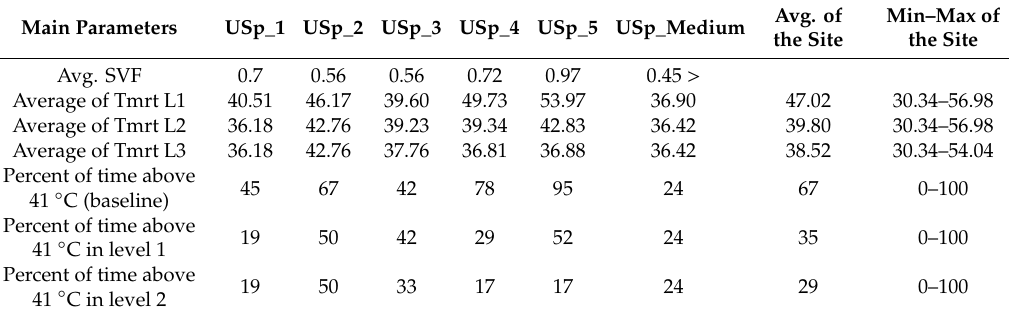
Table 4. The average of mean daytime Tmrt in di ff erent urban spaces where vegetation strategy is applied during the hottest period of day